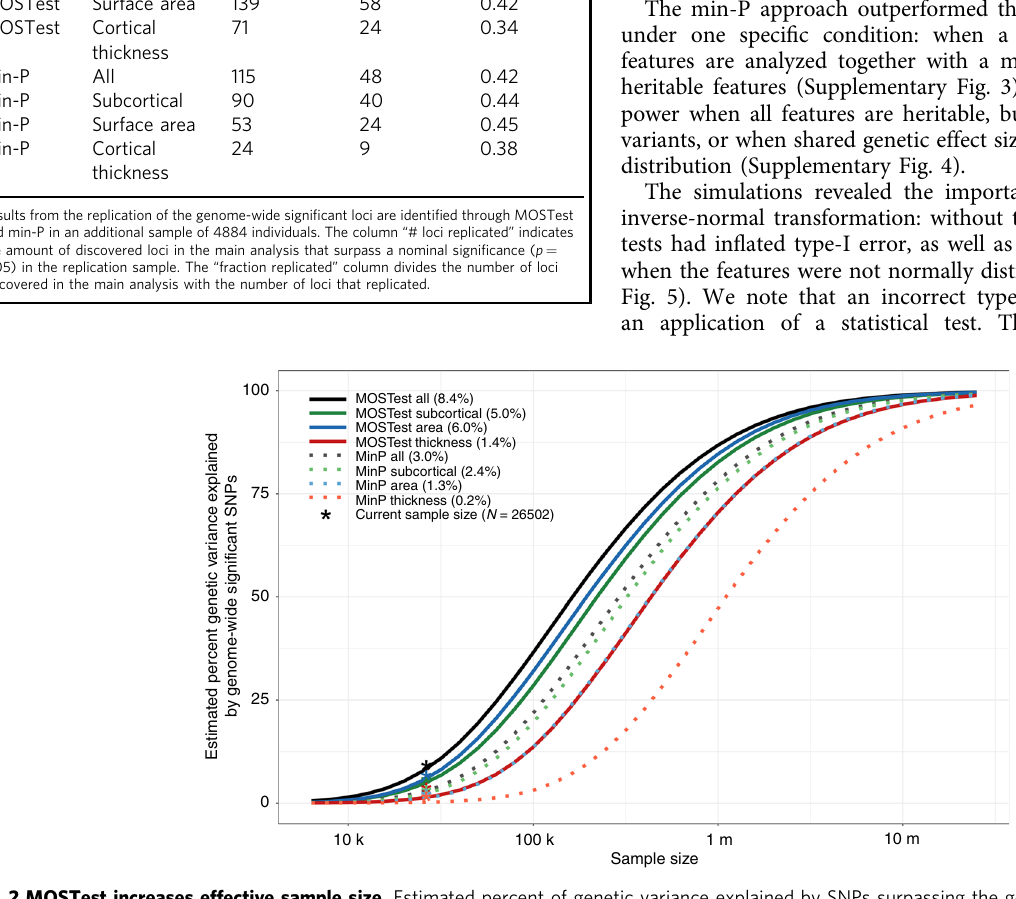
Fig. 2 MOSTest increases effective sample size. Estimated percent of genetic variance explained by SNPs surpassing the genome-wide signi fi cance threshold, on the y axis, as a function of sample size, depicted on the x axis on a log 10 scale, for each of the feature sets and for both MOSTest and min-P methods. Percentages of genetic variance explained by discovered SNPs with current sample size ( N = 26,502) are shown in